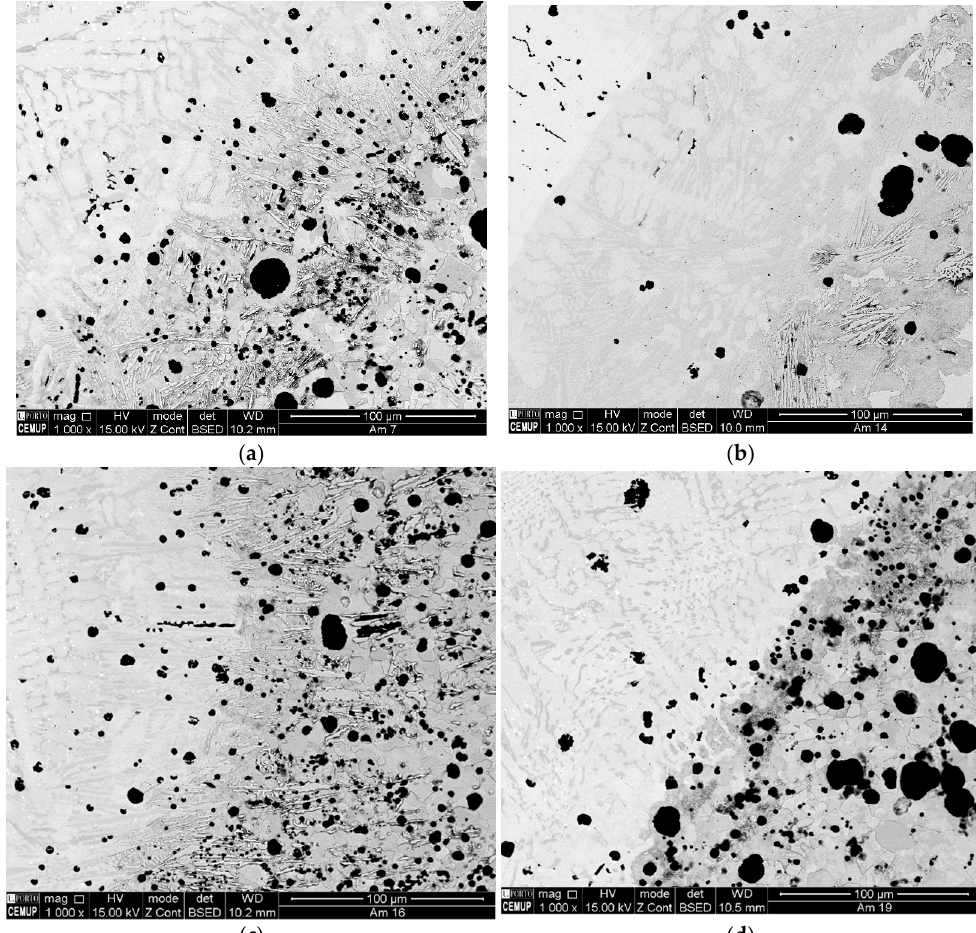
Figure 4. SEM microscopic analysis at 1000× magnification with a 4% Nital etching; ( a ) sample